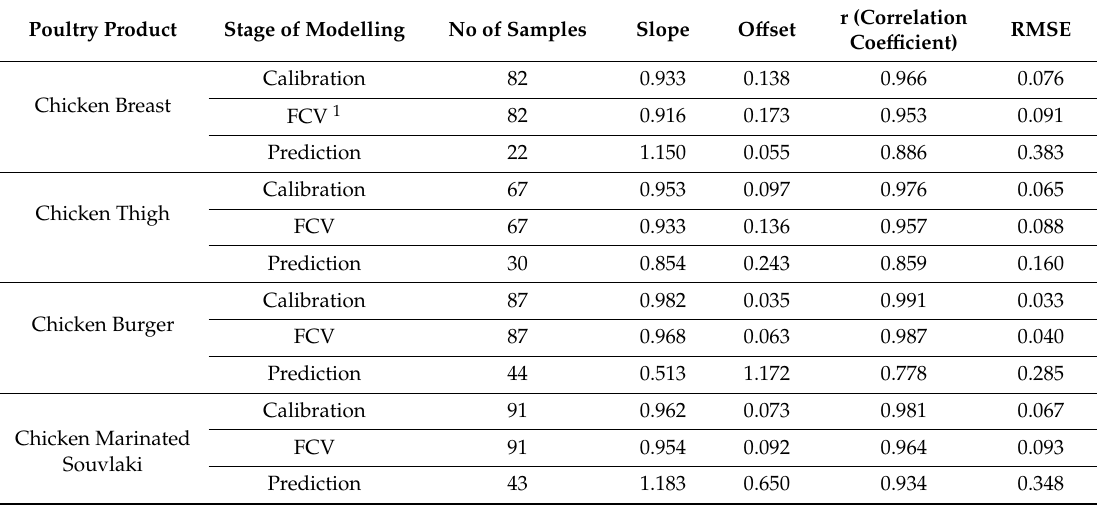
Figure 3. Comparison of observed (open symbols) and predicted (solid symbols) values of time from slaughter (log t s ) after the development of the PLS-R model. Solid line depicts the line of equity (y = x) and dashed lines are ± 1.6 log t s (i.e., 48 h after slaughter). Table 1. Performance indices (slope, offset, r and RMSE) for PLS-R model development and validation for each poultry product.